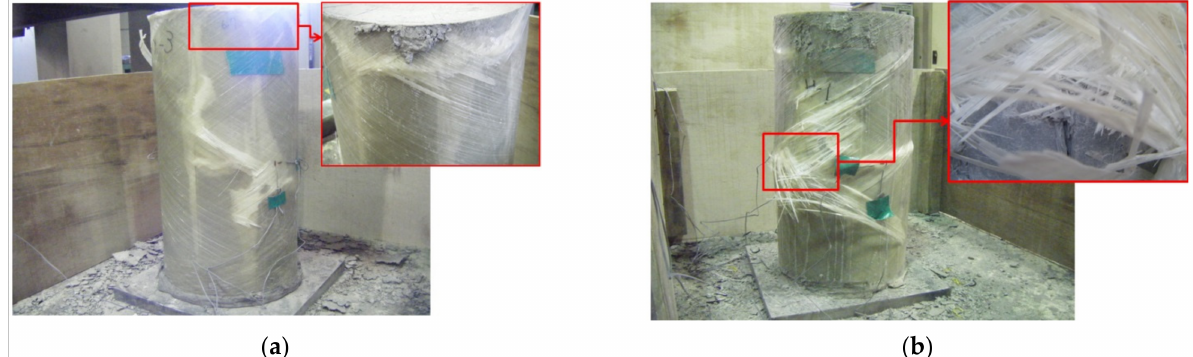
Figure 14. Compressive fracture types in the hybrid-CFFT. ( a ) FFRP delamination and ( b ) strand